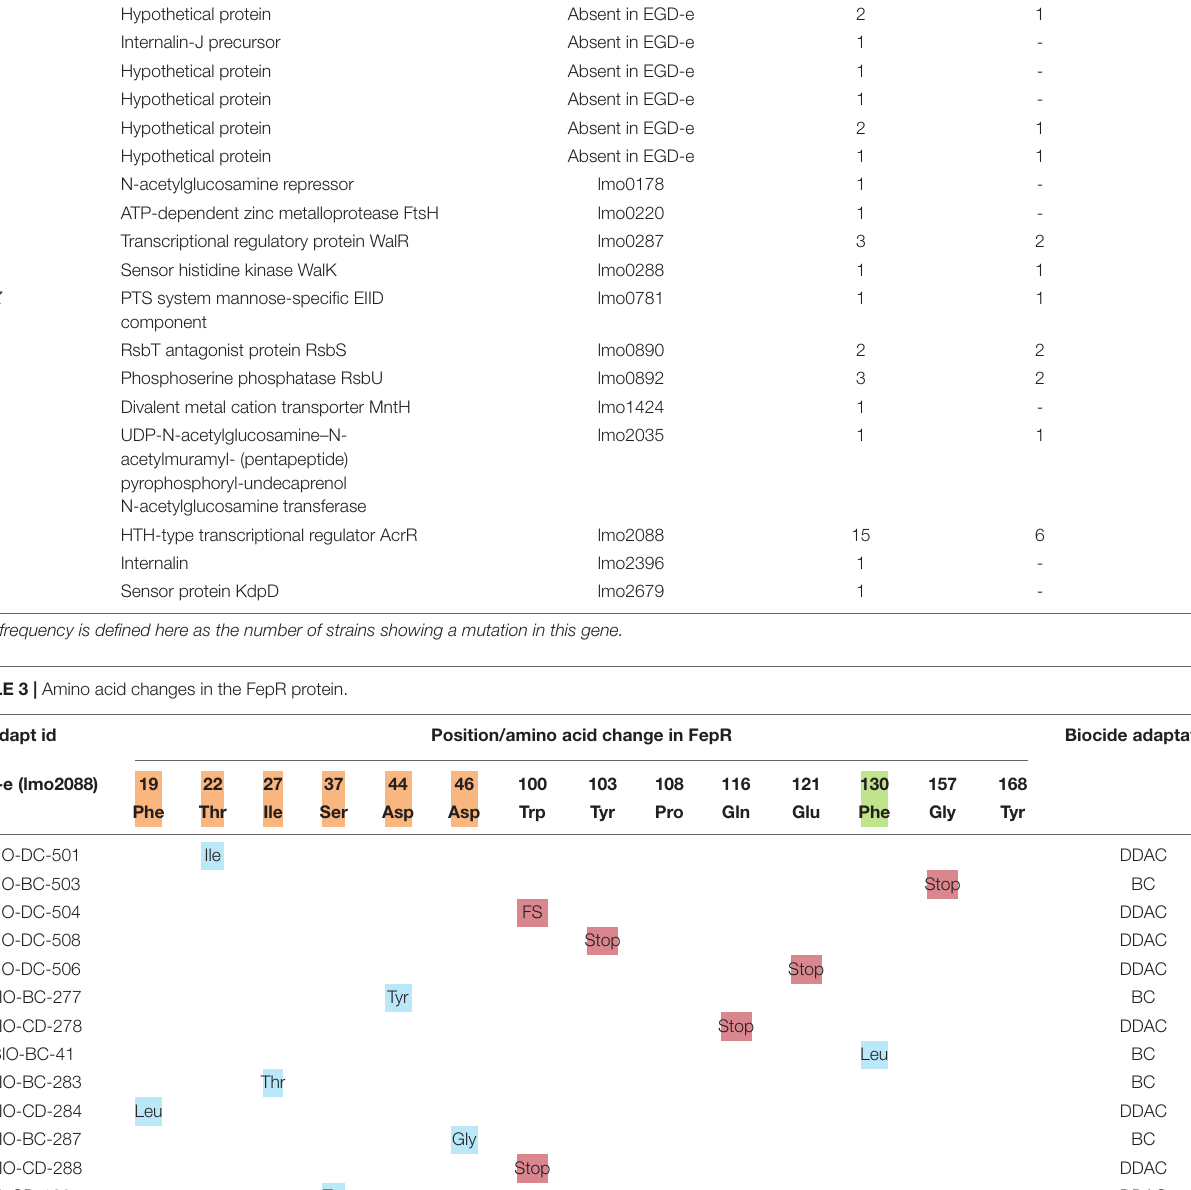
TABLE 2 | Genes presenting mutations in the 16 adapted strains [7 strains adapted to benzalkonium chloride (BC) and 9 strains adapted to didecyldimethylammonium chloride (DDAC)]. Gene